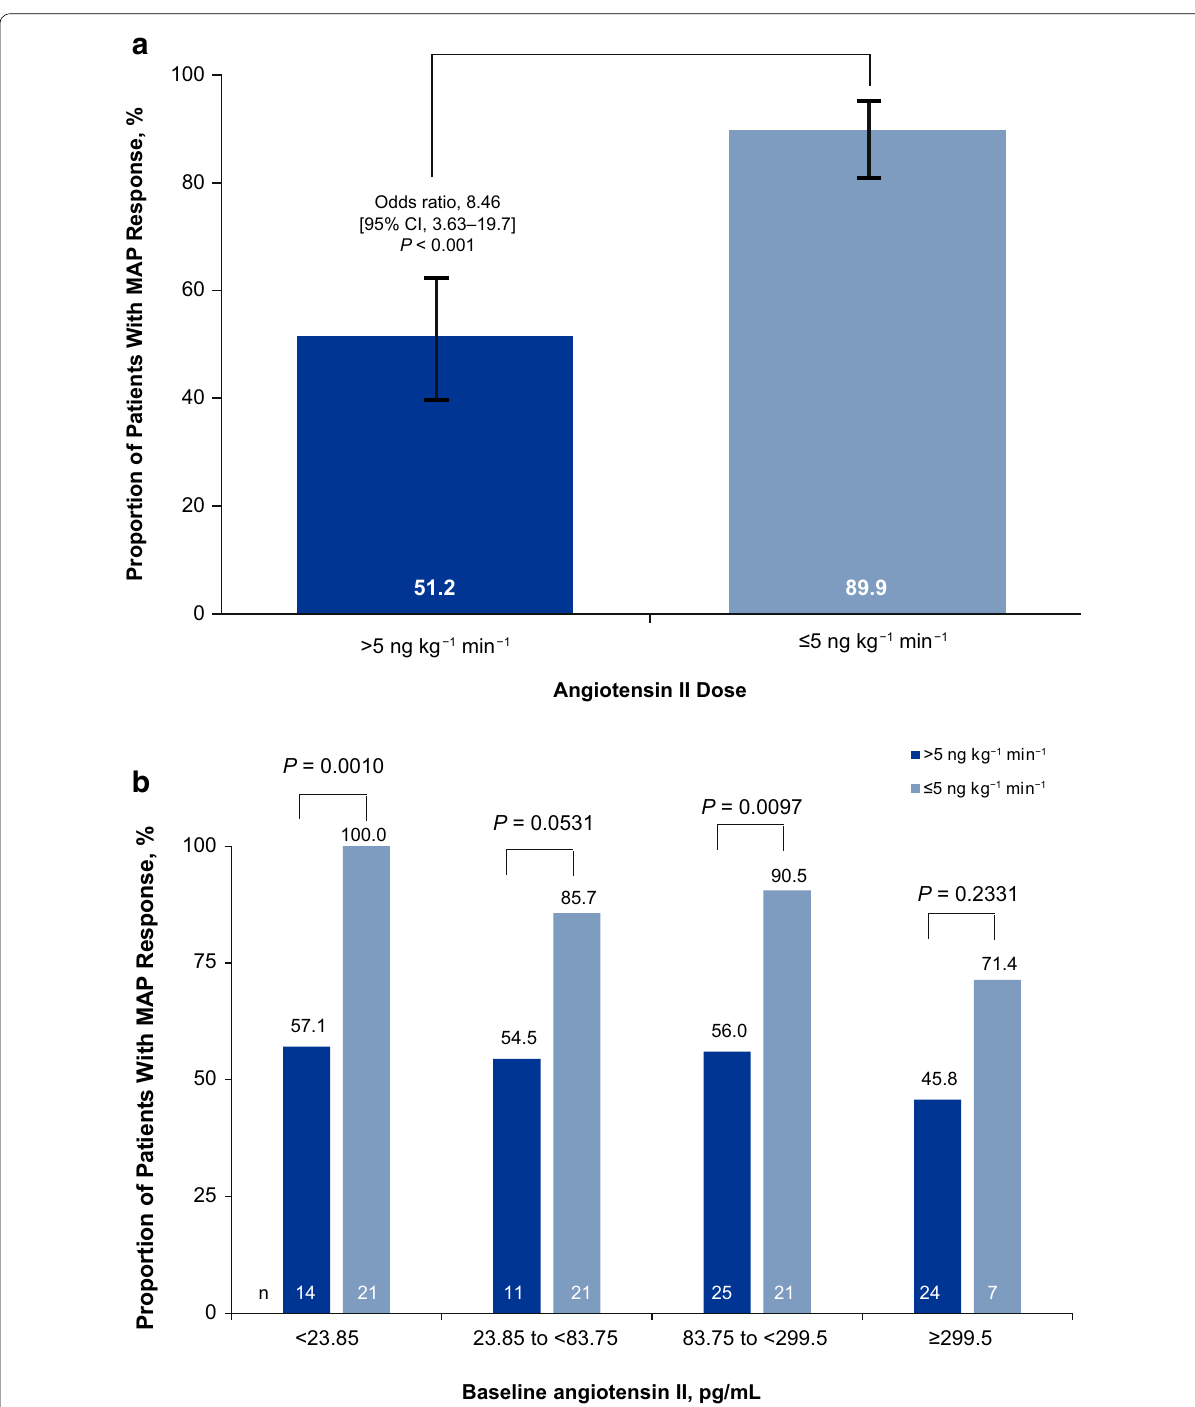
Fig. 1 Proportion of patients who had a MAP response at hour 3 by their angiotensin II dose, at 30 min following study initiation; > 5 ng kg − 1 min − 1 versus 5 ng kg − 1 min − 1 ( a ). Proportion of patients who had a MAP response at hour 3 by their angiotensin II dose at 30 min and quartiles of ≤ baseline angiotensin II ( b ). CI, confidence interval; MAP, mean arterial